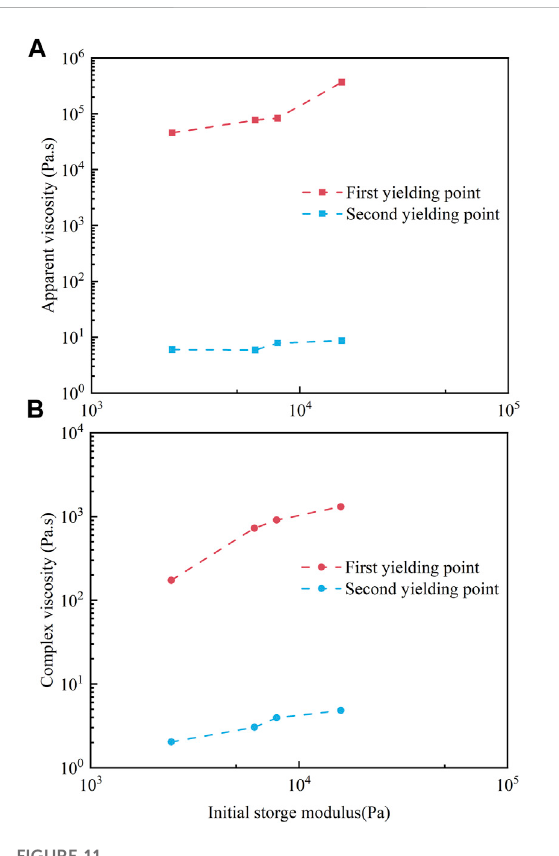
FIGURE 11 Variations of apparent viscosity (A) and complex viscosity (B) as functions of initial storage